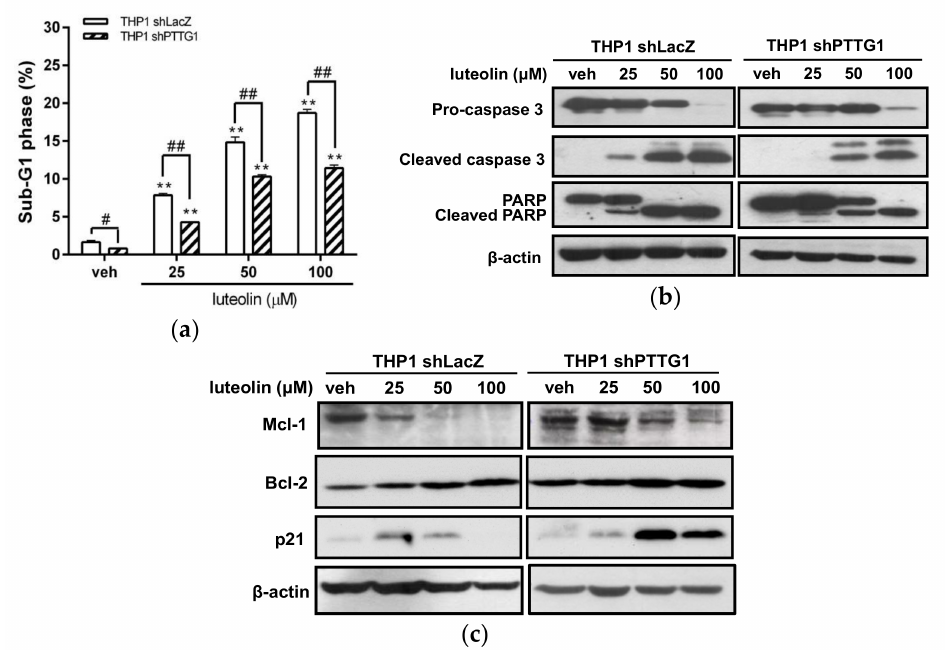
Figure 7. Effects of luteolin on the apoptosis of PTTG1-knockdown THP-1 cells. The THP1 shLacZ and shPTTG1 cells were treated with vehicle or luteolin (25–100 µ M) for 24 h. ( a ) Cell population in the sub-G1 phase was determined by flow cytometric analysis. The experiments were triplicated, and the data are presented as the means ± SD from three independent experiments. ** p < 0.01 represents a significant difference compared to the vehicle group (veh). # p < 0.05 and ## p < 0.01 represent a significant difference compared to the THP1 shLacZ control cells. ( b ) The protein expression levels of pro-caspase 3, cleaved caspase 3, PARP1, cleaved PARP1 and β -actin proteins were analyzed by Western blot analysis. The experiments were triplicated, and a representative blot is shown. ( c ) The Mcl-1, Bcl-2, p21 and β -actin proteins were analyzed by Western blot analysis. The experiments were triplicated, and a representative blot is